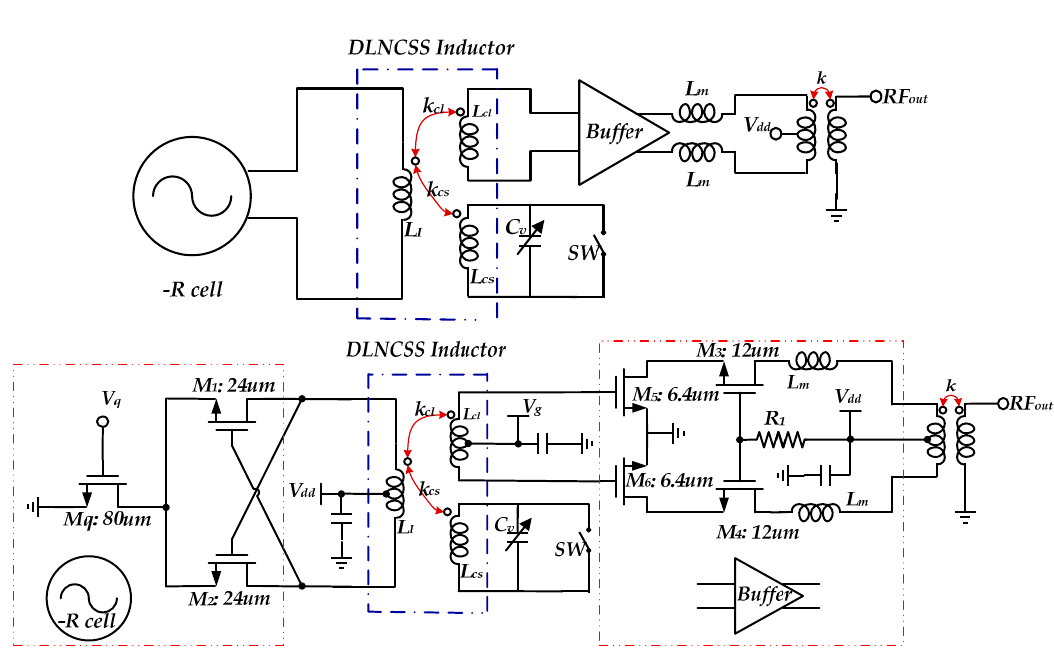
Figure 6. The schematic of the proposed D-band voltage control oscillator (VCO) with DLNCSS inductor.